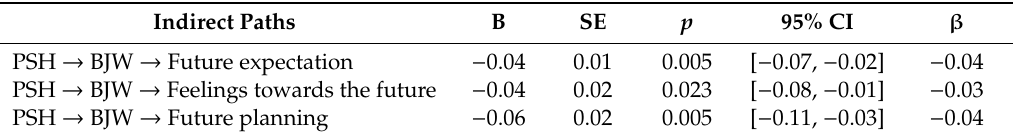
Table 3. Summary of the mediation e ff ects of belief in a just world in the association between perceived social hardship and future orientation. Indirect Paths B SE p 95% CI β PSH → BJW → Future expectation − 0.04 0.01 0.005 [ − 0.07, − 0.02] − 0.04 PSH → BJW → Feelings towards the future − 0.04 0.02 0.023 [ − 0.08, − 0.01] − 0.03 PSH → BJW → Future planning − 0.06 0.02 0.005 [ − 0.11, − 0.03] −